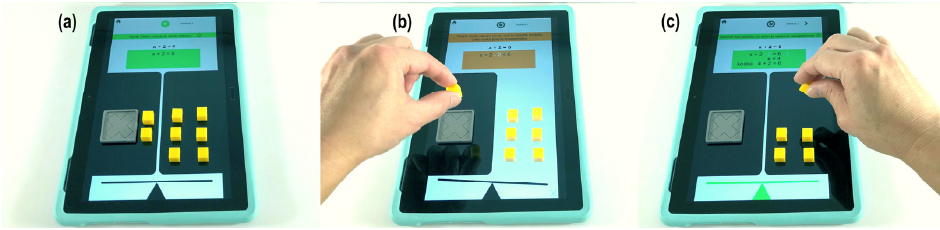
Figure 2. How to complete the level 2 exercise x + 2 = 6. ( a ) Equation modelling. ( b ) Equation solving by performing the same operation on both sides of the equation. ( c ) The digital scale is balanced when the equation is solved (from [16] (p. 10) CC BY-NC).